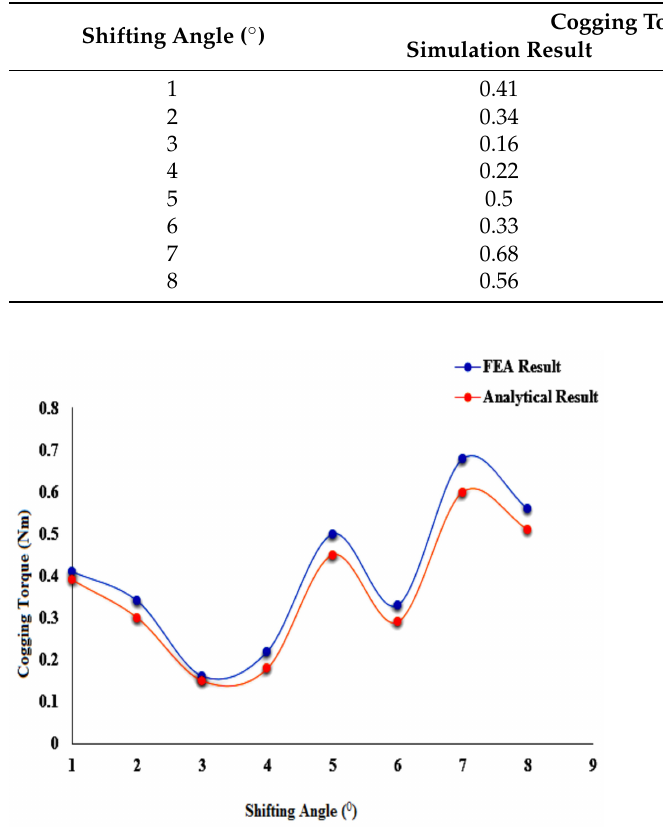
Figure 12. Comparison of FEA and analytical results. The magnet shifting can reduce the cogging torque effectively without deteriorating the trapezoidal shape of the back-EMF. Figure 13 shows the back-EMF of the SPMBLDC motor with different magnet shifting angles. In this figure, 0 ◦ represents all four magnets being placed at an exactly 90 ◦ phase difference from one another, and is represented using blue color. The yellow color, which is very close and similar to the 0 ◦ case, phase shifts the